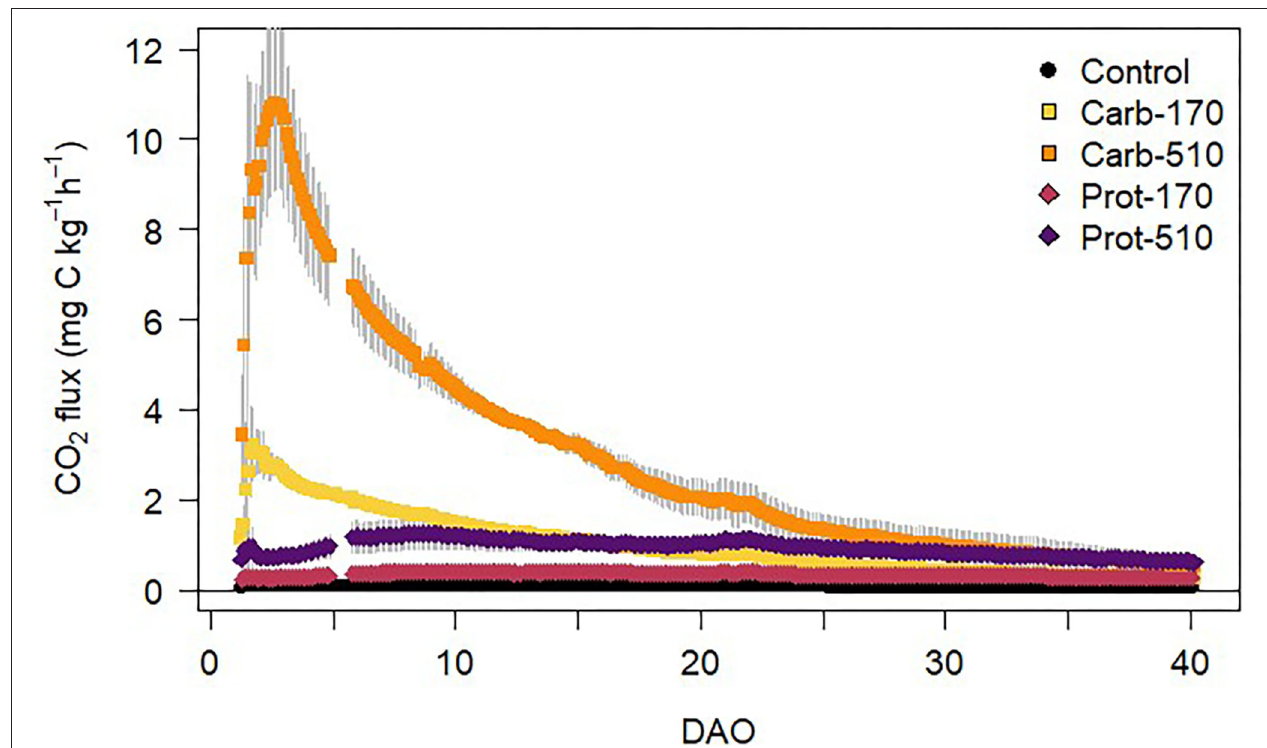
FIGURE 3 | CO 2 fluxes from soil during the incubation experiment (mean ± standard deviation for n = 4, for Prot-170 n = 3).